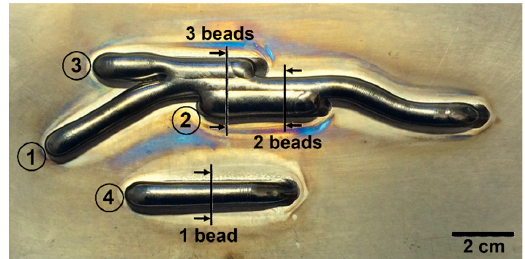
Figure 1. The built feature consisting of the four sequences of ten layers in height, including the starting positions and sequence order. The arrows indicate the position for microstructural characterization of each cross-section.